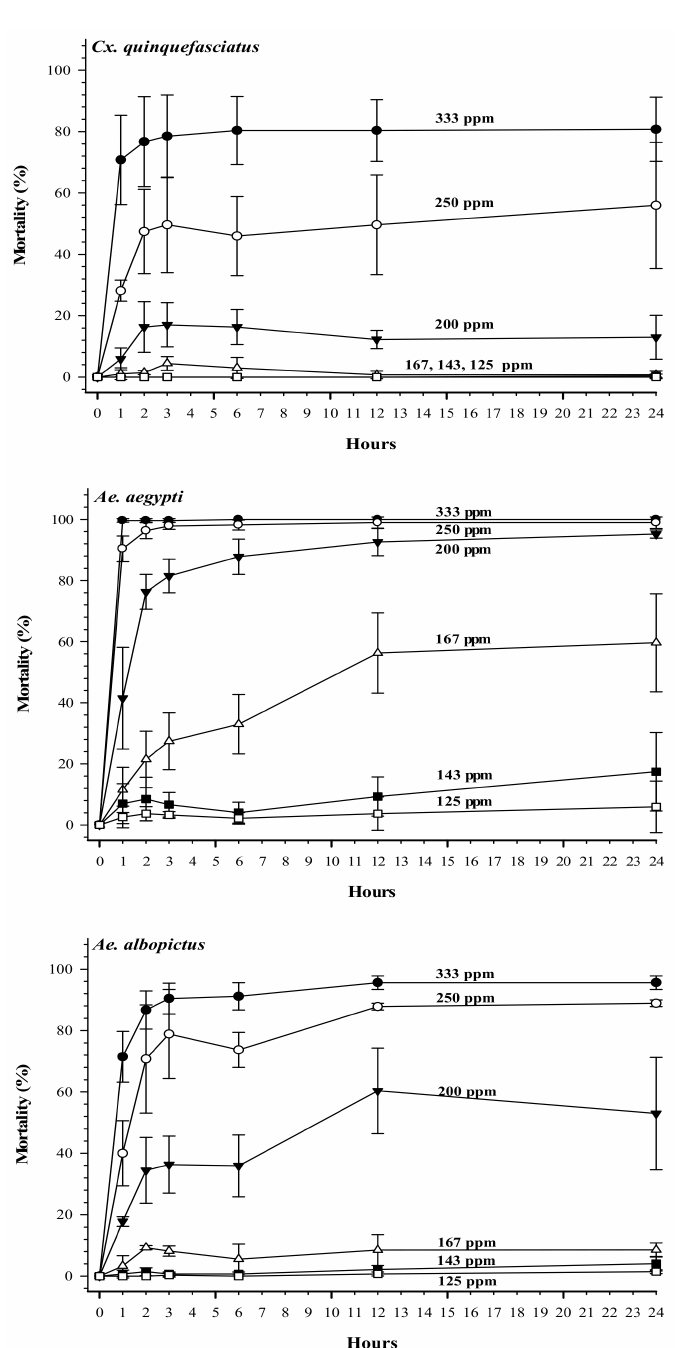
Figure 2. Time effects of terahertz-based functional mineral water on mosquito larval mortality (%). The third instar larvae were reared in reverse osmosis (RO) water containing various con- centrations of terahertz-based functional mineral water, and mortality of larvae was recorded at time points indicated on the x-axis. Data are presented as mean ± SE values from at least three independent experiments, and different letters indicate significant differences ( p < 0.05) between different concentrations at each